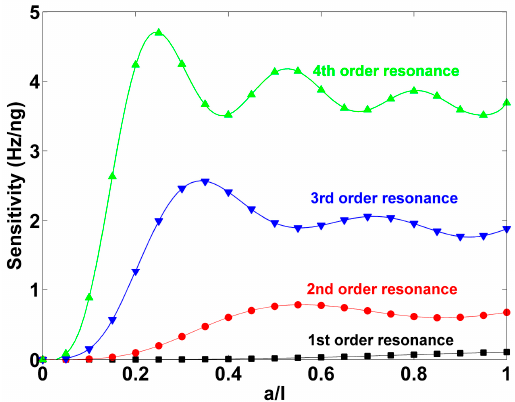
Figure 5. The behavior of sensitivity of the cantilever as the change of mass distribution under different resonance modes where ρ m A m / ρ 0 A 0 = 1.